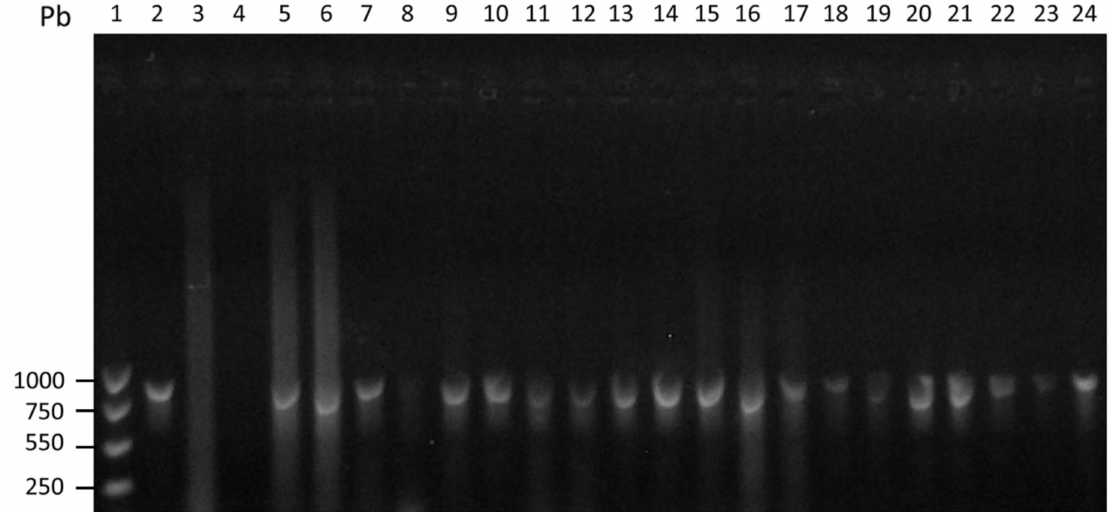
Figure 2. PCR identification of E. histolytica . The DNAs obtained from samples of tissue fragments from lesions of genital cutaneous amebiasis patients and abscess drainage from patients with amoebic liver abscess, were evaluated by PCR using oligonucleotides specific (Psp) previously described by Clark and Diamond [26]. Lane (1) 1000 pb mass ruler DNA ladder; (2) Positive control for E. histolytica strain HM1: IMSS; (3) Negative control for E. histolytica ; (4) H 2 0 sample; (5–19) DNA obtained from drainage from patients with amoebic liver abscess; (20–24) DNA obtained from lesions of genital cutaneous amebiasis patients. Products amplified and stained with ethidium bromide, Product size 876 bp.